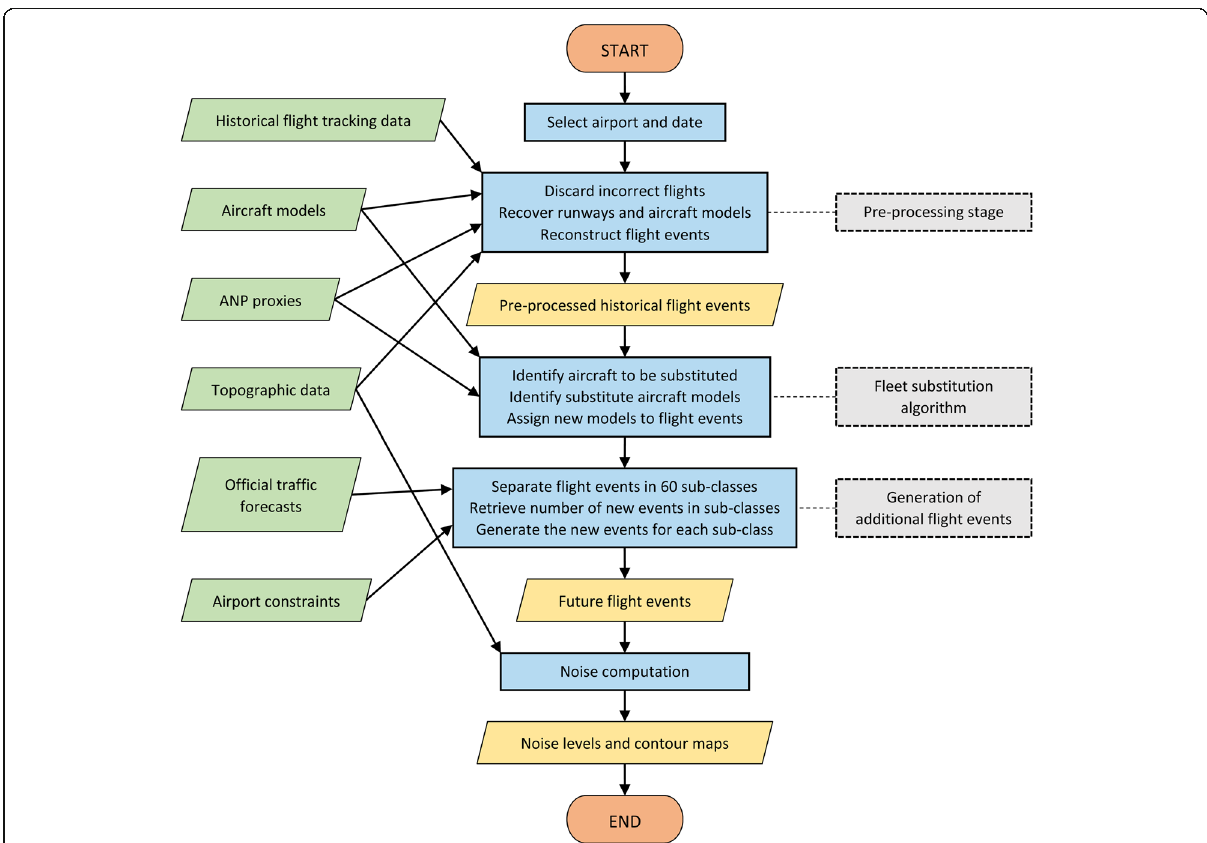
Fig. 1 Flowchart describing the key steps of the present approach. The input data are listed on the left-hand